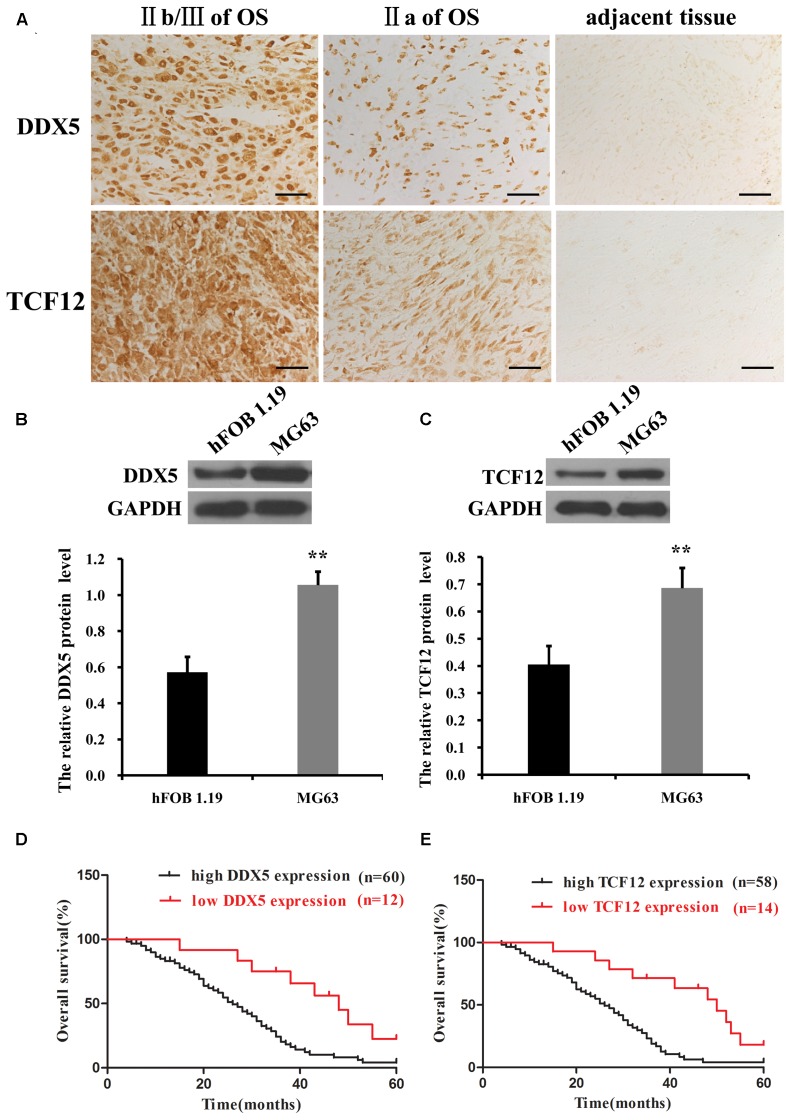
Expressions of DDX5 and TCF12 in human OS tissues, MG63 OS cells and associated with overall survival. (A) Expressions of DDX5 and TCF12 in IIa, IIb/III specimens and the adjacent normal tissue by IHC staining, bar = 50 μm. (B) Western blot analysis on DDX5 protein in the OS MG63 cells and in the hFOB 1.19 cells (n = 4), ∗∗P < 0.01 vs. hFOB1.19 group. (C) Western blot analysis on TCF12 protein in the OS MG63 cells and in the hFOB 1.19 cells (n = 4), ∗∗P < 0.01 vs. hFOB1.19 group. (D) Kaplan–Meier survival analyses of the OS patients. High DDX5 expression was associated with short survival. (E) Kaplan–Meier survival analyses of the OS patients showed high TCF12 expression was associated with short survival.